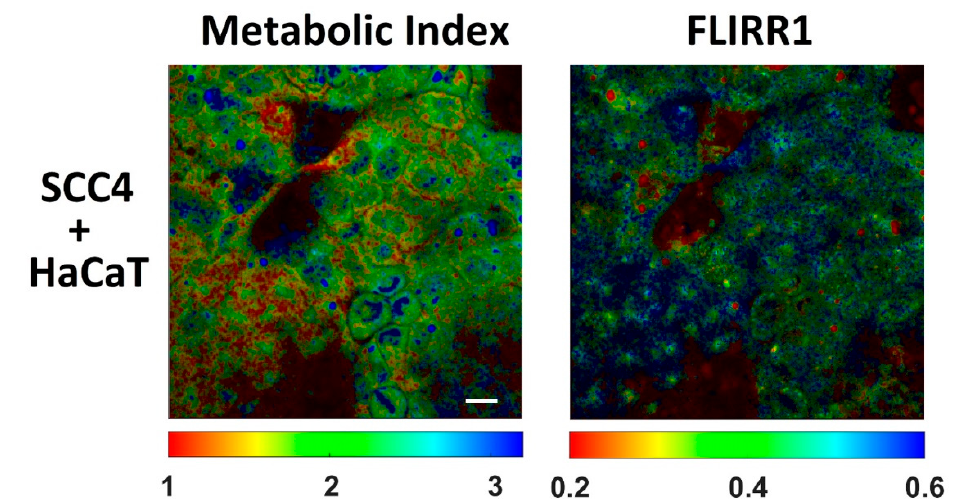
Figure 4. Fluorescence lifetime images of co-cultured HaCaT and SCC4 cells. The autofluorescence of NAD(P)H was recorded in the “green” (426–446 nm) spectral channel under 780 nm two-photon excitation whereas the autofluorescence of flavins was collected in the “red” (542–582 nm) spectral channel under 880 nm two-photon excitation. Scale bar 20 µm.